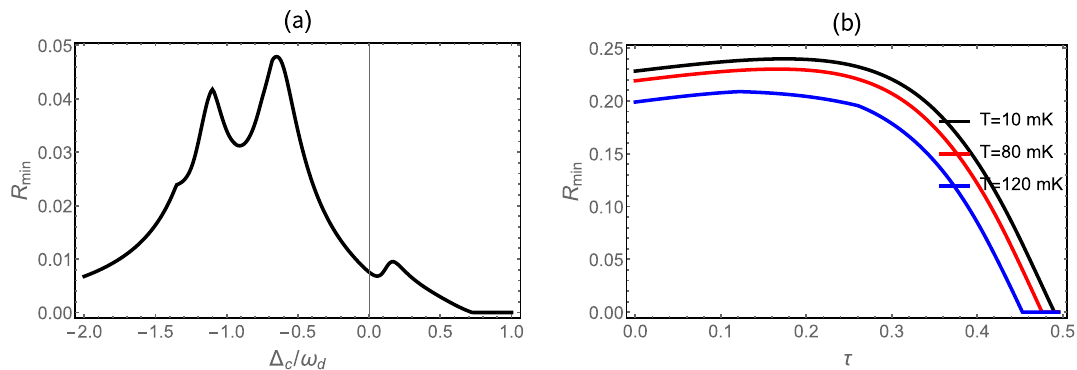
Figure 4. ( a ) Plot of tripartite entanglement in terms of the minimum residual contangle R min versus normalized detuning � c /ω d with n d reflectivity τ for different values of the temperature T (Blue). We take G md / 2 π